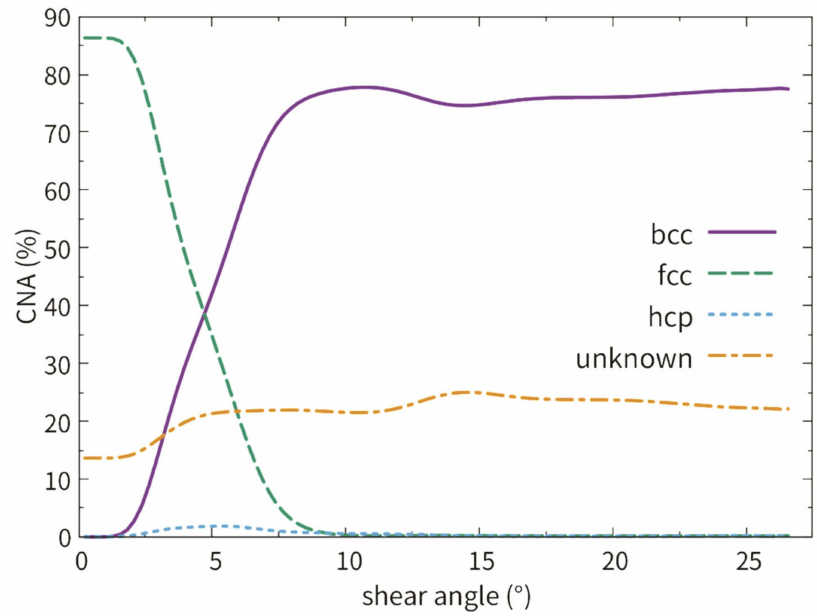
Figure 4. Fractional phase contents of film 1 with (111) fcc free surface as a function of shear angle at a temperature of 300 K. Hcp: hexagonal close